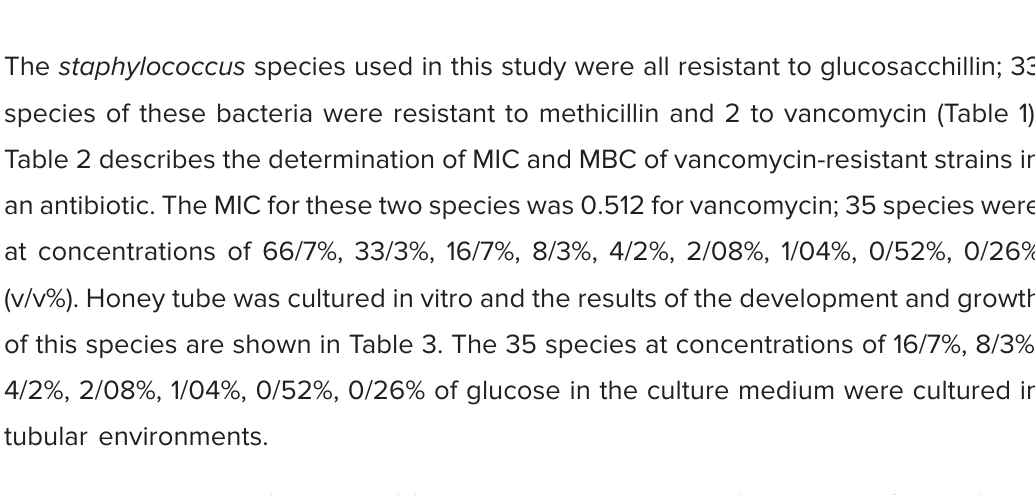
Table 1: The Prevalence of Antibiotic of Staphylococcus Aureus Isolated from the Nasal Swabs of Tohid Hospital